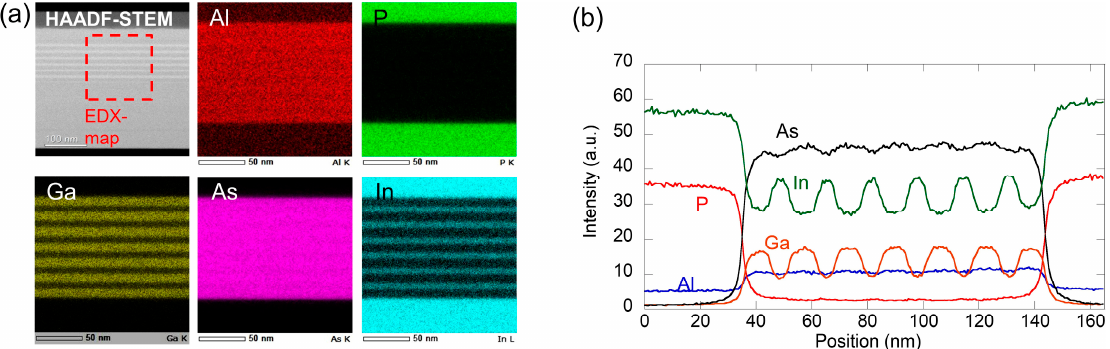
Figure 8. ( a ) Cross-sectional energy dispersive X-ray spectrometry (EDX) map of MQW-BH on InP-on-insulator substrate; ( b ) extracted line profile along depth